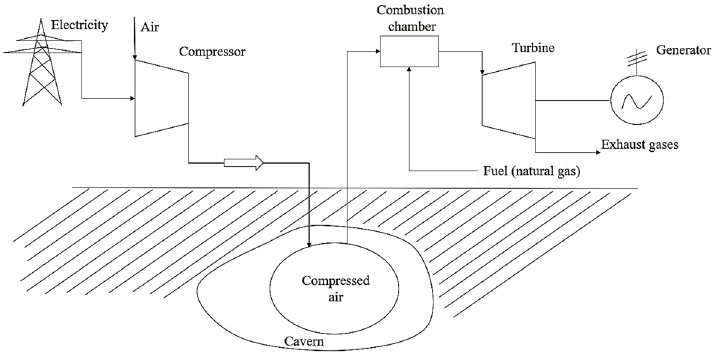
Figure 6. Compressed air energy storage system.